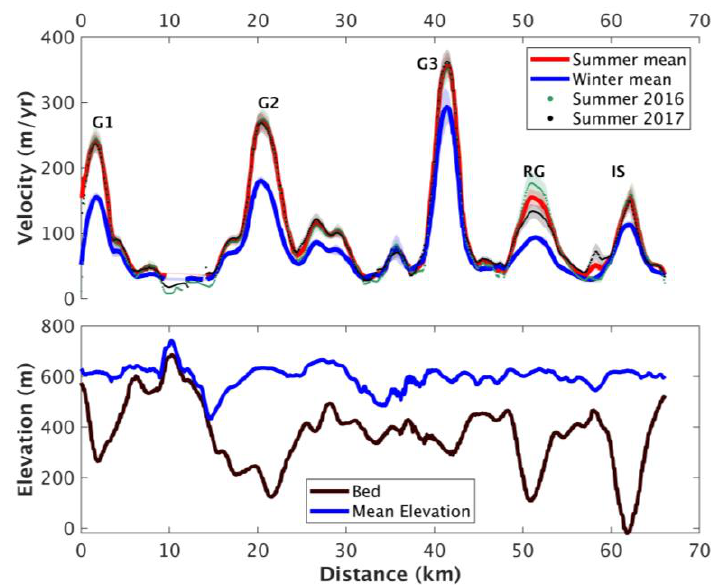
Figure 3. Ice velocity ( Top ), with uncertainty ranges represented by the light shading, and geometry ( Bottom ) along an across-flow profile of the study area (see Figure 1 for location) in 2016 to 2017.